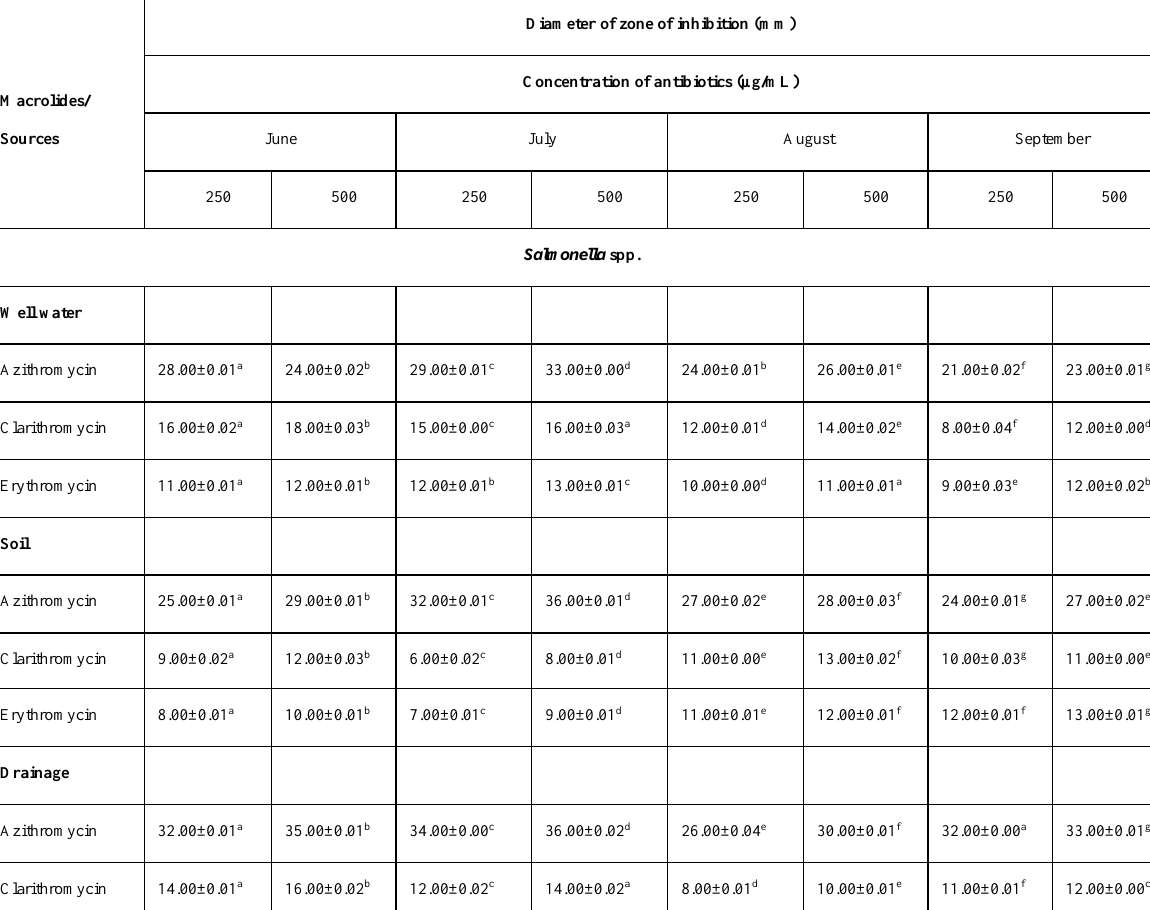
Table 2. Susceptibility patterns of bacterial isolates in Erifun